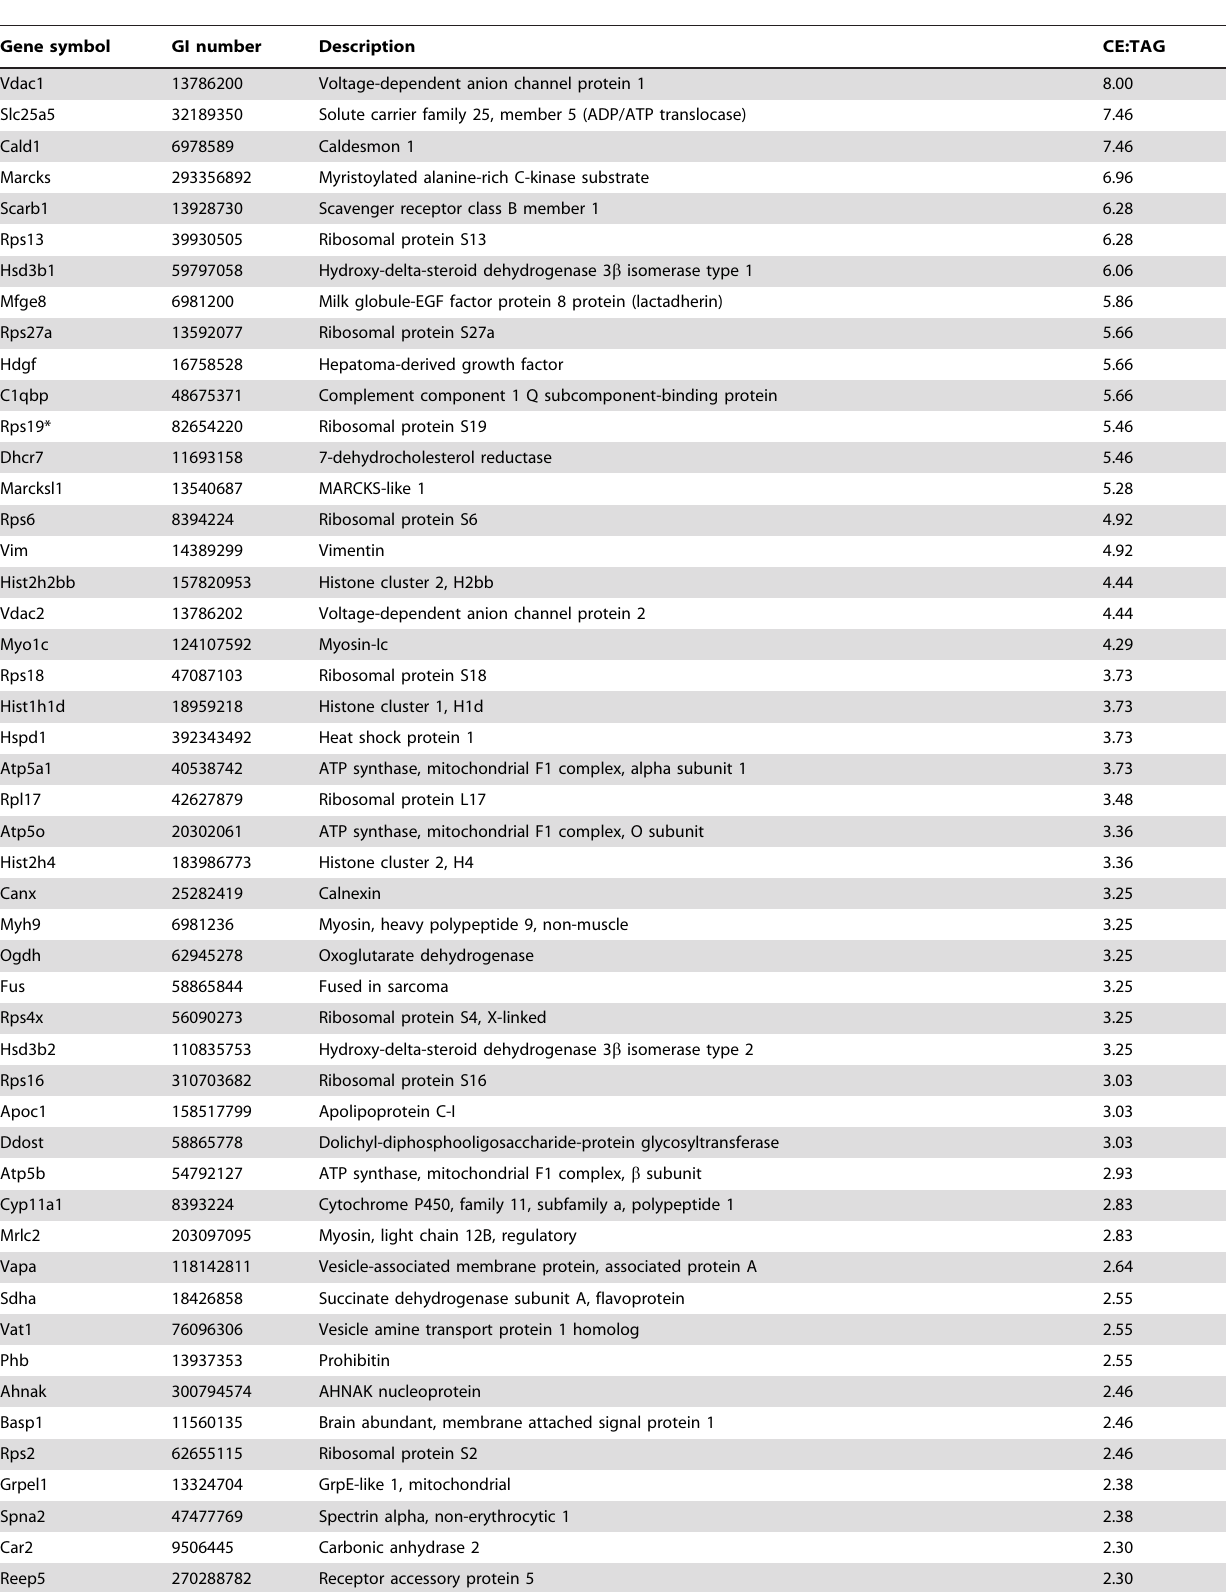
Table 1. List of proteins found in greater abundance in CE-enriched LDs versus TAG-enriched LDs by tandem mass tags based